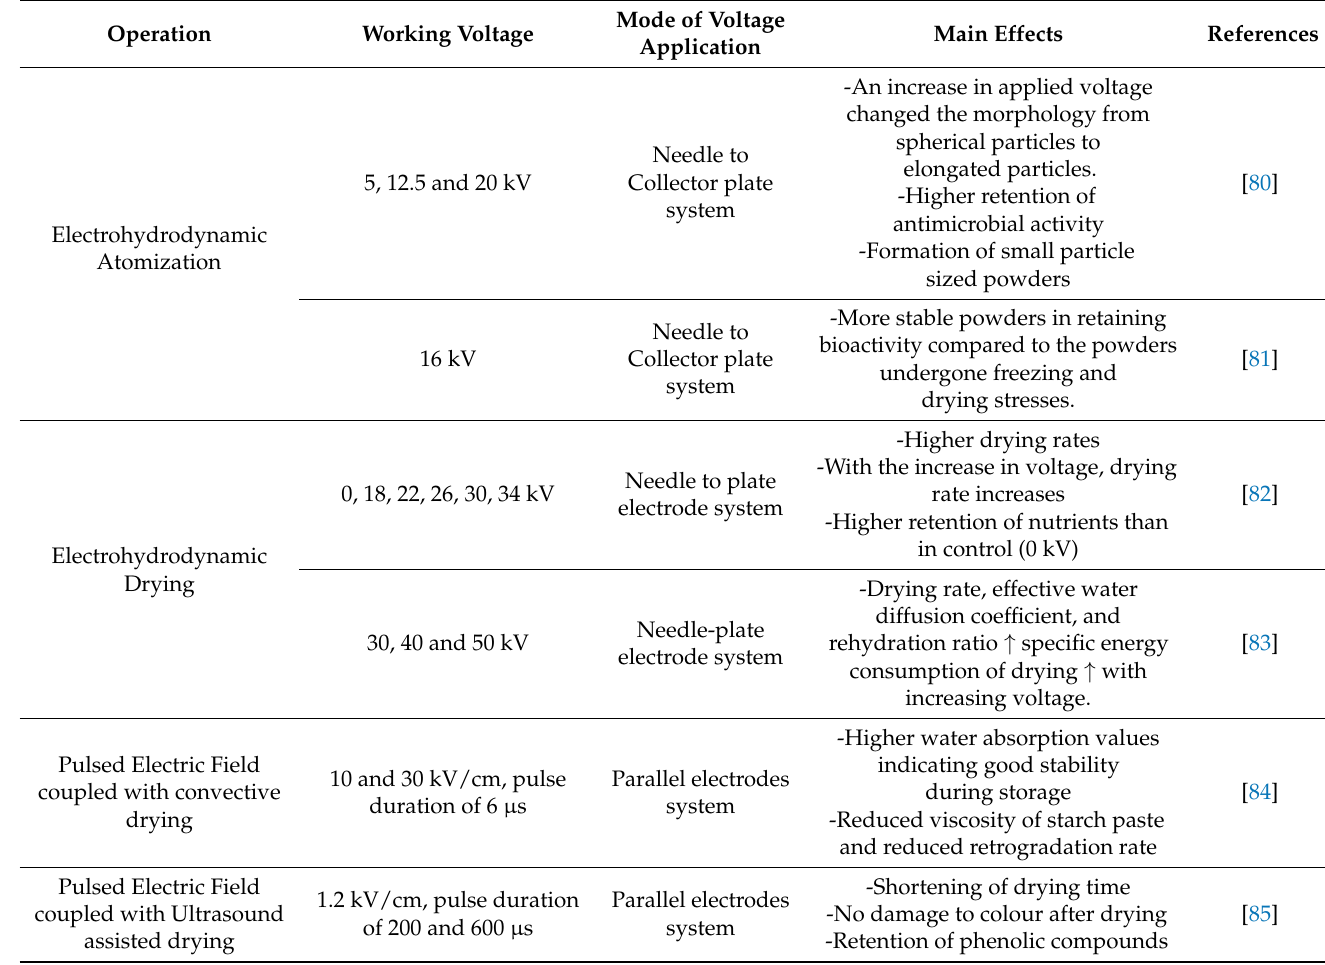
Table 1. Summary of some recent works on the electrohydrodynamic techniques with their working voltage, mode of voltage application and their main